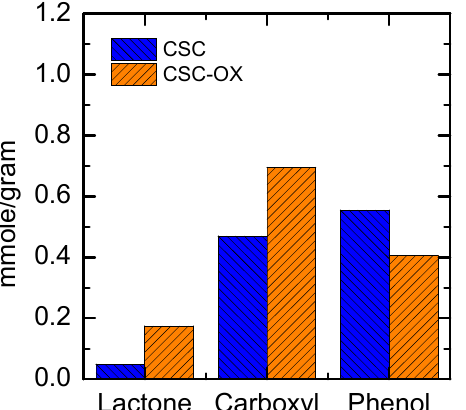
Figure 5. Analysis result of the acid group before and after the oxidation process with the Boehm titration method of CSC and CSC-OX.